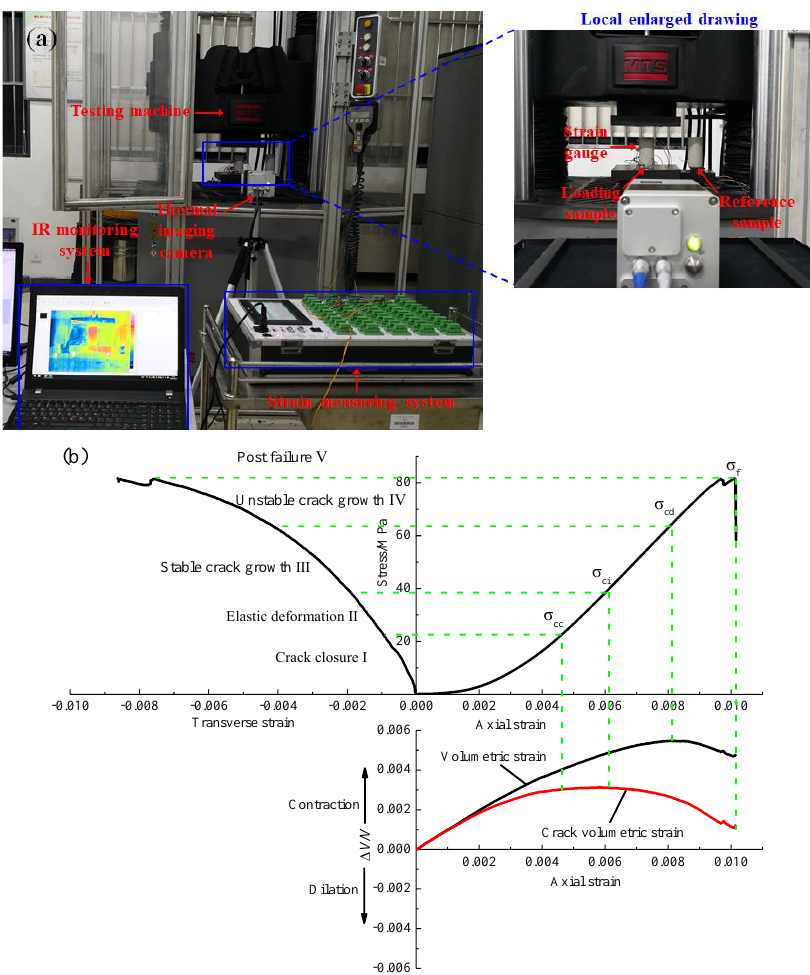
Figure 2. The mechanical testing system and the stress – strain behavior of the sample. ( a ) Experimental set-up; ( b ) Damage evolution during uniaxial loading of sandstone sample A 13 . Crack initiation threshold σ ci is the onset of crack volumetric increase that is the reversal point of crack volumetric strain; critical damage threshold σ cd is the reversal point of the total volumetric strain.